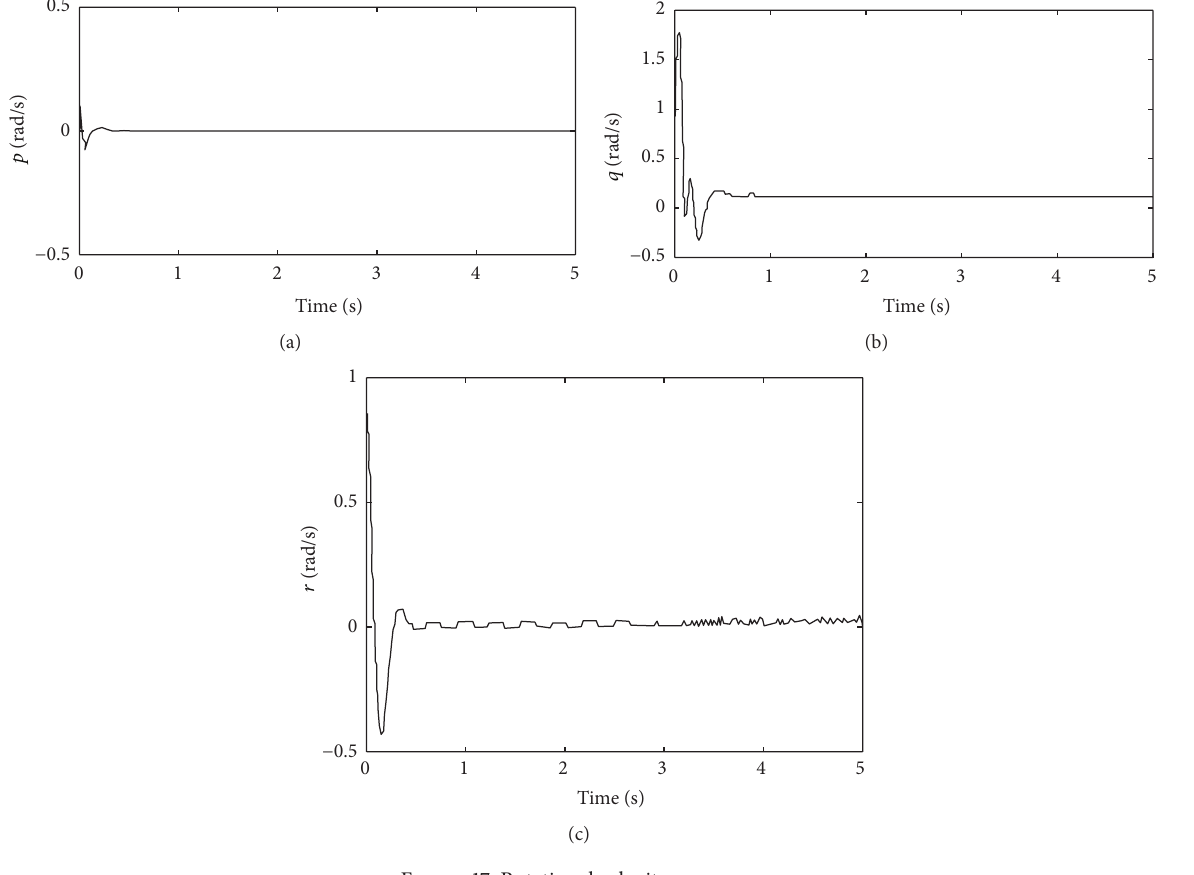
Figure 17: Rotational velocity responses.